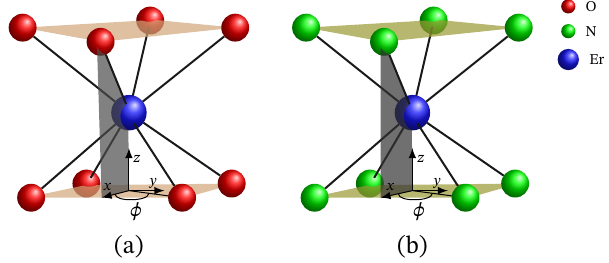
Figure 1. Square antiprismatic structure of Er 3 + in: ( a ) Na 9 [Er(W 5 O 18 ) 2 ] with twist angle φ ≈ 42.79 ◦ and structural information reported in Reference [9]; ( b ) [(Pc)Er{Pc{N(C 4 H 9 ) 2 } 8 }] · with φ ≈ 43.69 ◦ and struc- ture discussed in Reference [24]. The dihedral angle of the reduced form [(Pc)Er{Pc{N(C 4 H 9 ) 2 } 8 }] − is 41.40 ◦ . The red, green and blue spheres depict oxygen, nitrogen and erbium elements, respectively. Another class of attractive erbium–based single ion magnets includes [(Pc)Er{Pc{N(C 4 H 9 ) 2 } 8 }] · / − [24]. The Er 3 + ion in these compounds is coordinated by